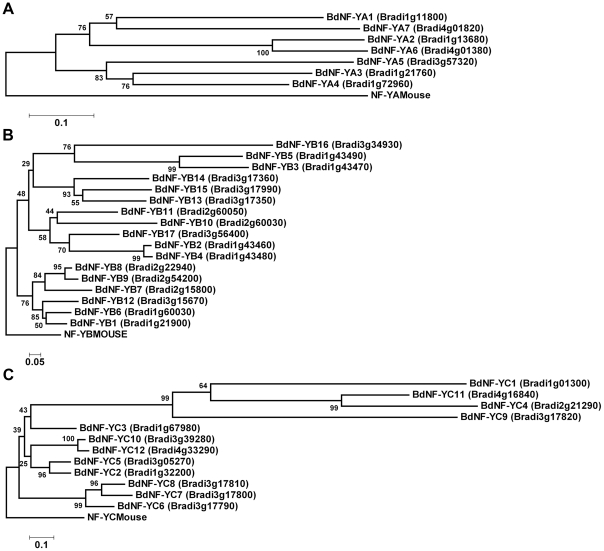
Phylogenetic trees for the Brachypodium BdNF-Y families.
A) BdNF-YA phylogenetic tree. B) BdNF-YB phylogenetic tree. C) BdNF-YC phylogenetic tree. For each BdNF-Y family, phylogenetic trees were constructed by neighbor-joining as implemented by Molecular Evolutionary Genetics Analysis (MEGA) software, version 4.0 [52]. Reliability values at each branch represent bootstrap samples (10,000 replicates). Note that BdNF-YB16 is orthologous to the DR1-related proteins and these are sometimes shown as a separate, NF-YB-like family [11], [16], [90]. There is no functional data to suggest that either choice is “correct,” but they are more closely related to NF-YB proteins than any other best match in BLAST searches. Thus, they are included here as related, but divergent NF-YB family members.